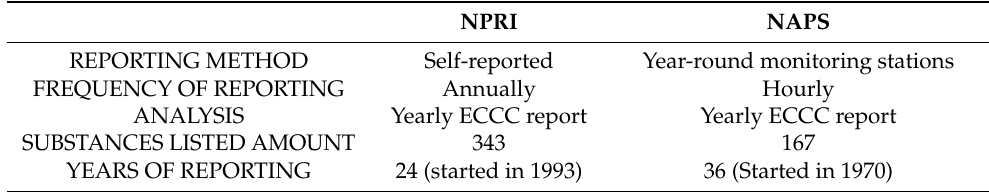
Table 1. Comparing NPRI and